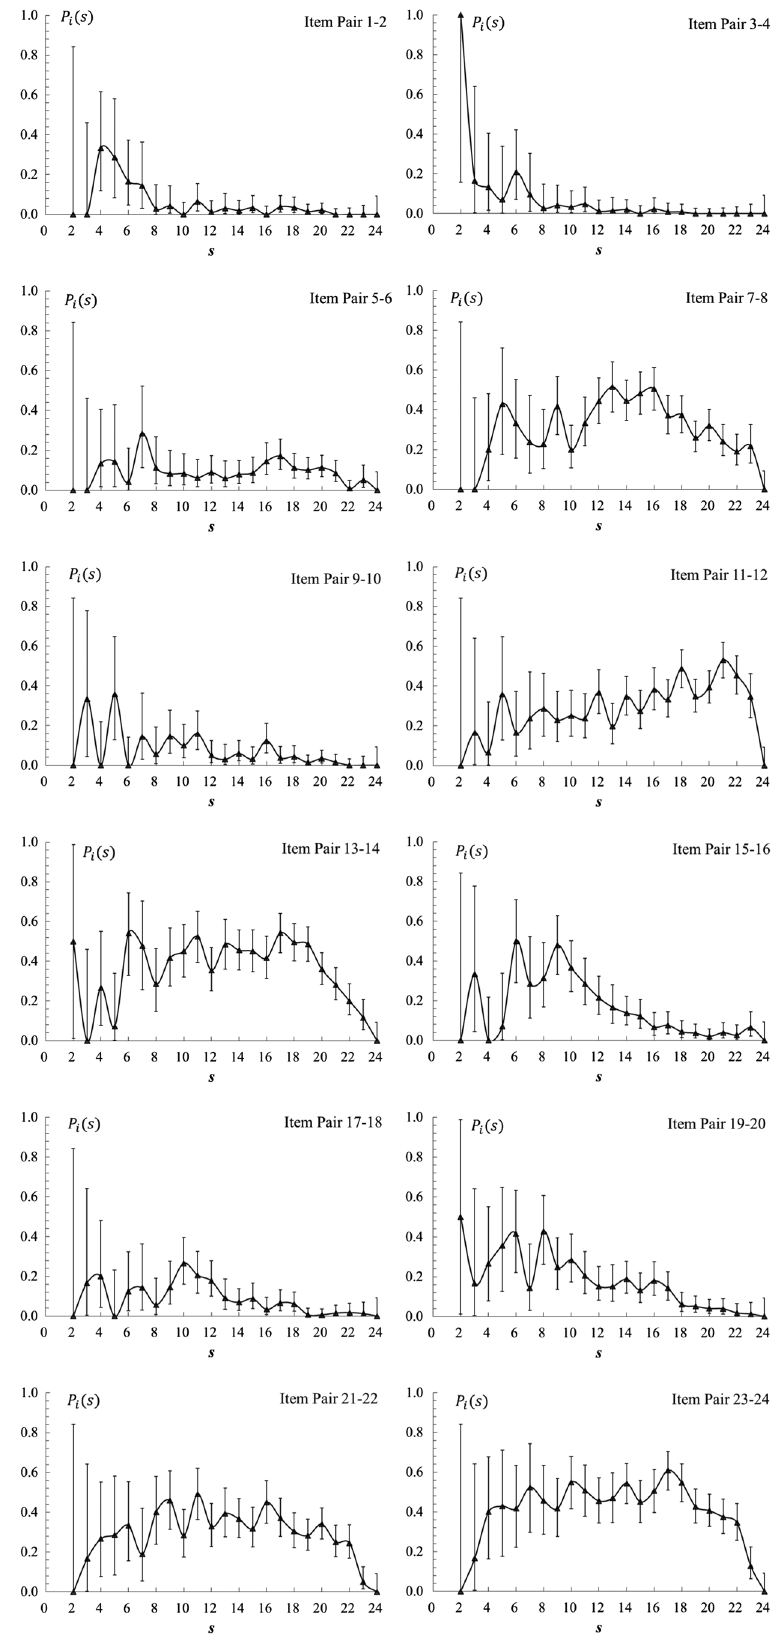
FIG. 3. The distribution of inconsistent patterns as a function of